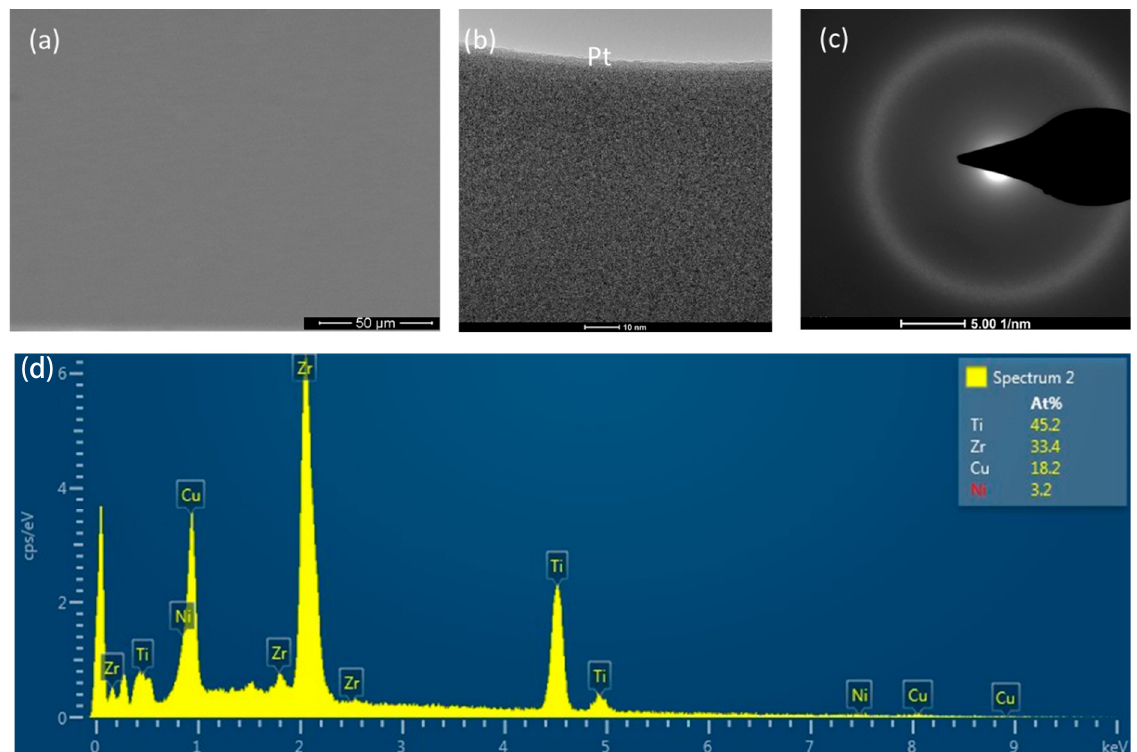
Figure 1. Microstructure of presently investigated Zr-based BMG: ( a ) SEM micrograph, ( b ) TEM micrograph, ( c ) diffraction pattern and ( d ) corresponding EDX spectra. Pt denotes platinum that was deposited to protect the material surface in the course of TEM sample preparation in FIB-SEM.